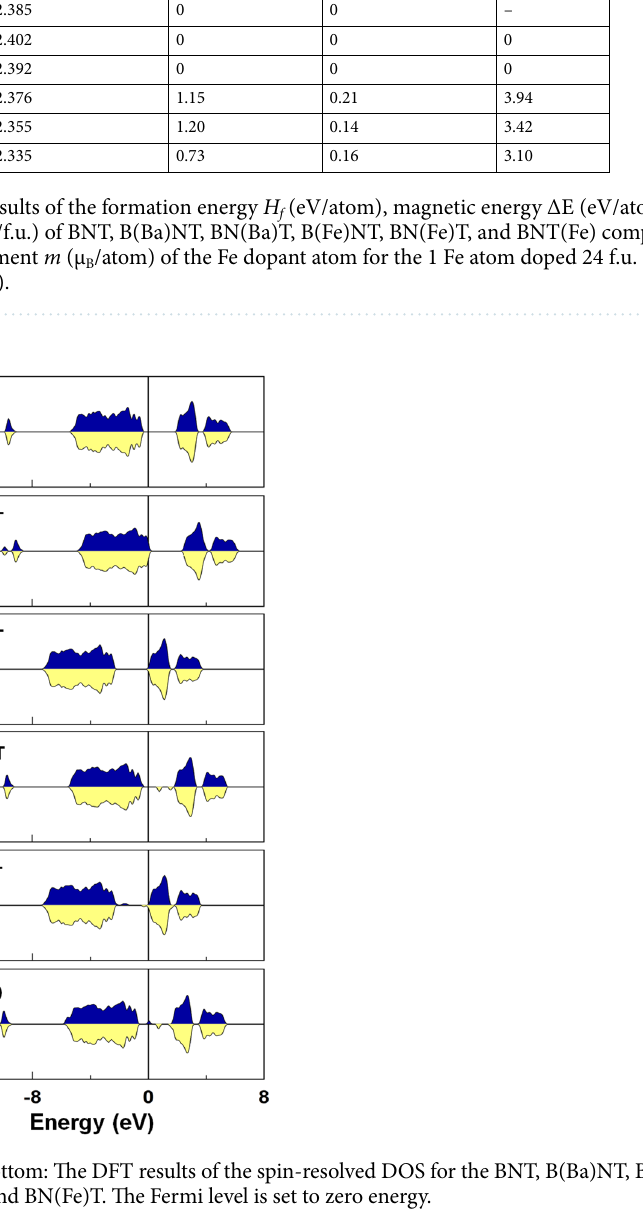
Fig. 11 for the selected B(Fe)NT, BN(Fe)T, and BNT(Fe) as they exhibit magnetic nature. For BNT, the valence and conduction bands are characterized by the O-2 p and Ti-3 d orbital states with a band gap of ~ 2.25 eV, respec-